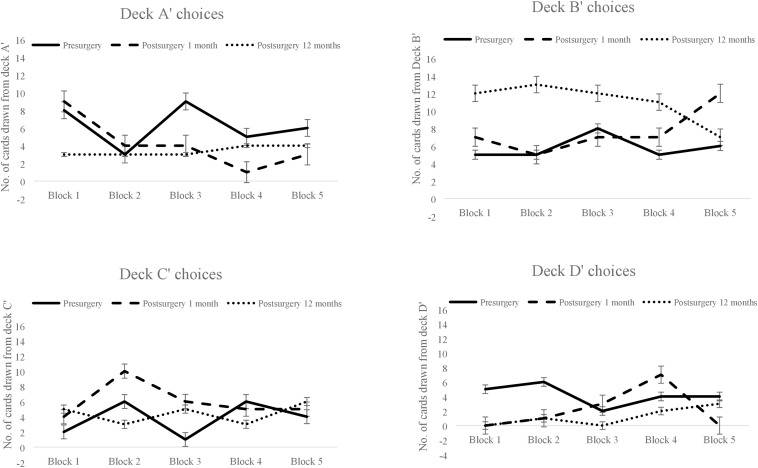
The patient’s pre- and post-surgical block-wise choices for each of the four decks in the Iowa Gambling Task. Block-wise deck A′ choices made pre-surgery, post-surgery within 1 month, and post-surgery after 12 months (top left-hand corner), similarly deck B′ choices (top right-hand corner), deck C′ choices (bottom left-hand corner) and deck D′ choices (bottom right-hand corner). Error bars show the standard error.